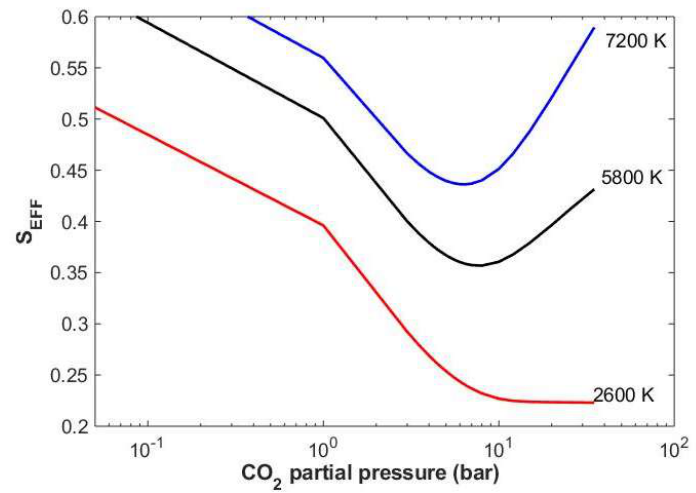
Figure 2. Plot of the effective stellar flux ( S EFF ) versus CO 2 partial pressure for F0 (7200 K, blue), G2 (5800 K, black), and M8 (2600 K, red) stellar types. S EFF decreases from the right to the curve minima